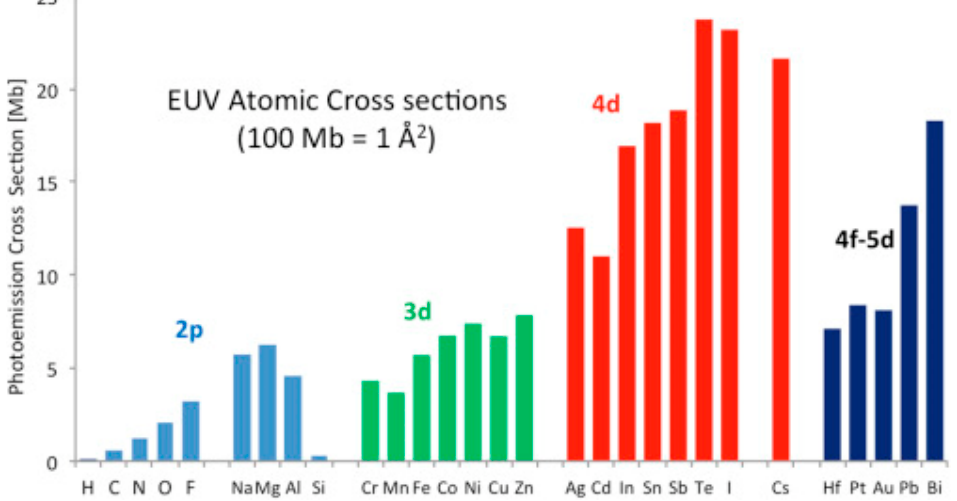
Figure 2. Photoemission cross sections at 92 eV calculated for selected atoms in Mb (Megabarn), where 1 Mb = 10 − 22 m 2 in SI units. Figure adapted from [30], with permission from Elsevier, 2020. The atoms encountered in a typical resist composition are carbon, oxygen, and hydrogen. As